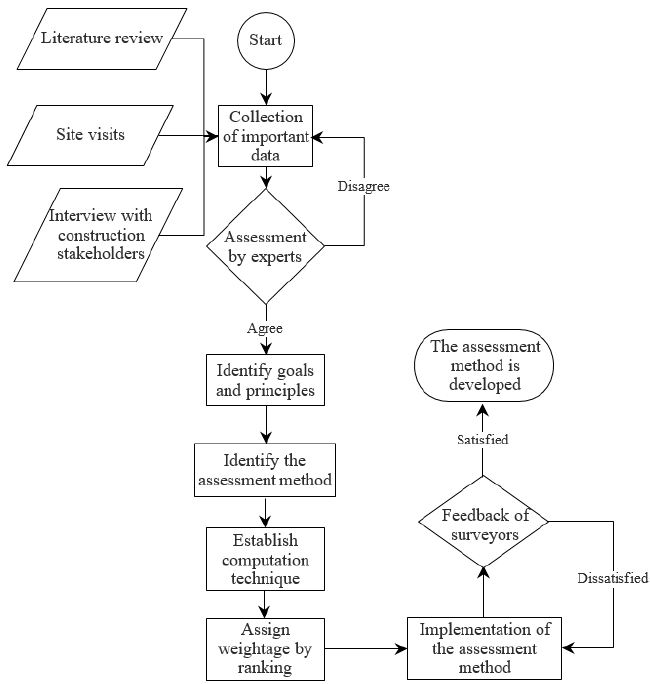
Figure 1. Overall flow chart to develop assessment method for remedial treatment.